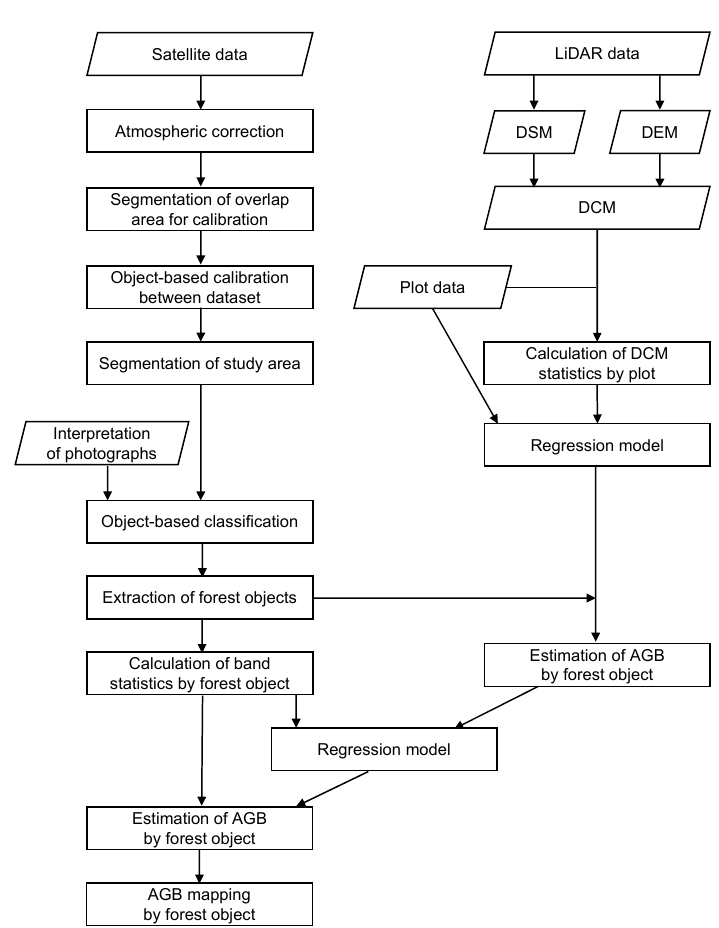
Figure 3. The workflow of the data analysis used for object-based mapping of AGB in tropical forests by combining VHSR satellite data with LiDAR data as the reference data.